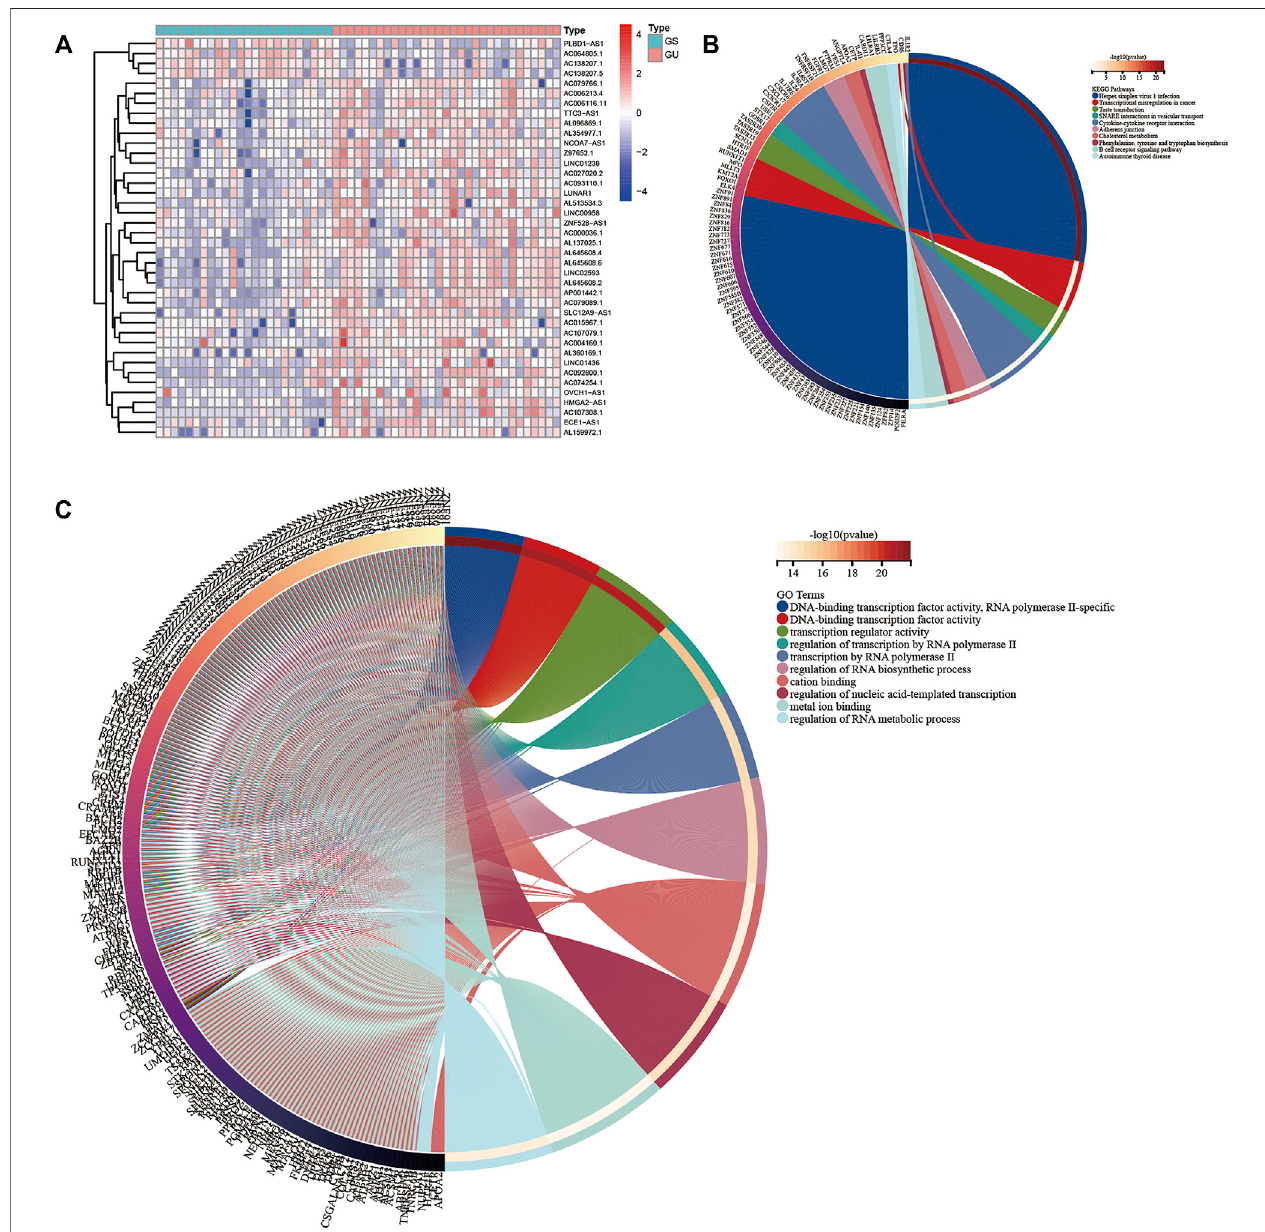
FIGURE 1 | (A) Heat map of the top 20 upregulated and downregulated lncRNAs. The upregulated and downregulated genes are marked red and blue, respectively. The top 10 mRNAs related to differentially expressed lncRNAs were selected as target genes. The Kyoto Encyclopedia of Genes (B) and Genomes and Gene Ontology (C) analysis maps of the target genes were